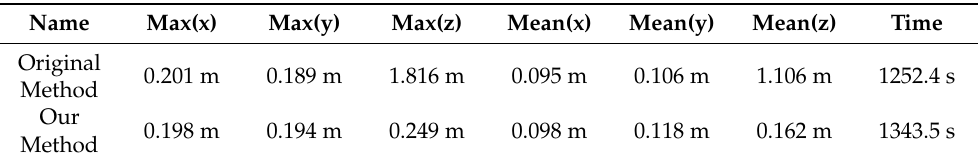
Table 1. Comparison of errors in different directions.